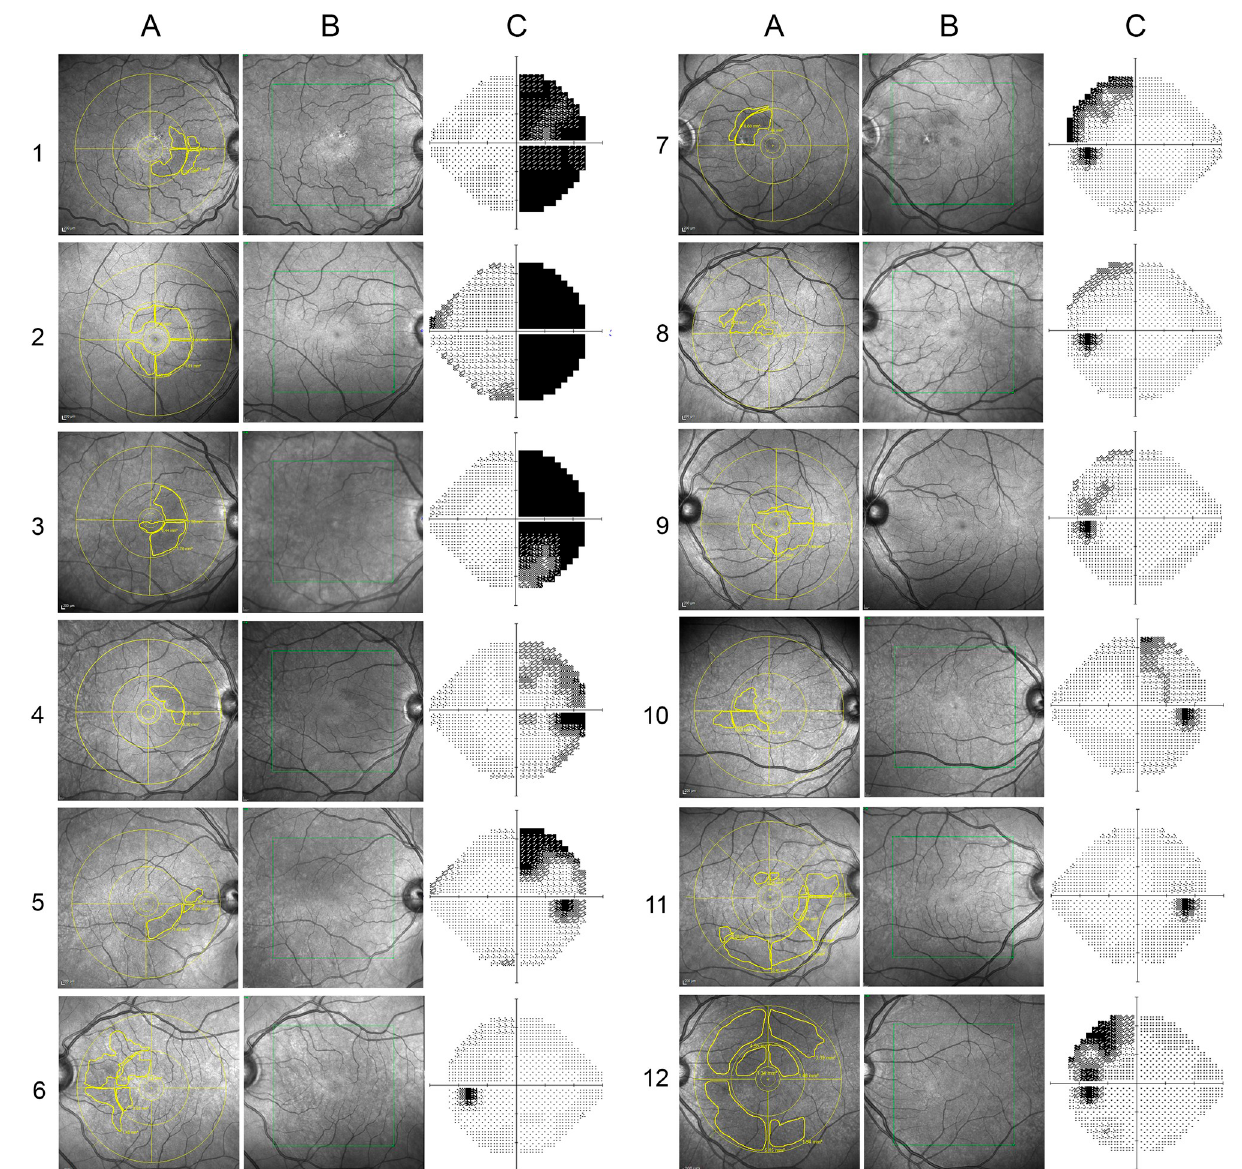
Fig 3. Near infra-red reflectance images and visual fields of 12 eyes labeled as having hyporeflective abnormalities but no microcysts on OCT (HA +MMA-). In eyes 1–8, the shape and location of the HA area (nasal hemi-macula, corresponding to the temporal VF defect) allowed to label it a true positive. In eyes 9–12, the location and/or size of the demarcated HA area, when compared to the extension of the VF defect, allowed to label it a false-